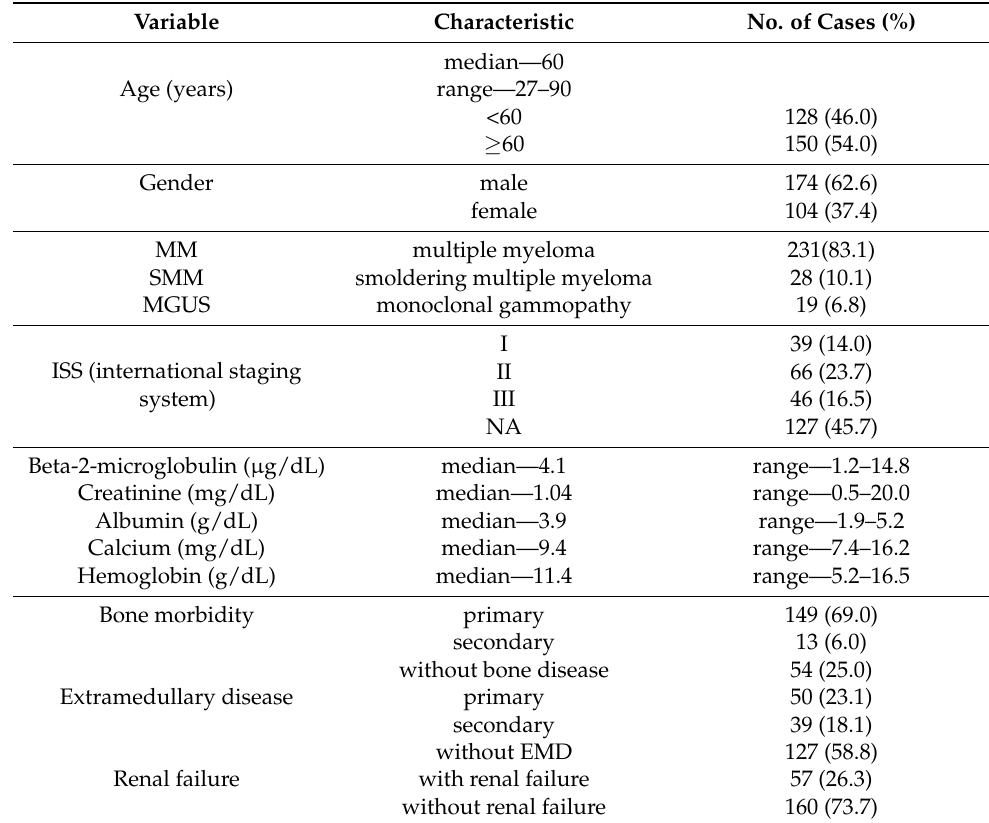
Table 1. Patient’s